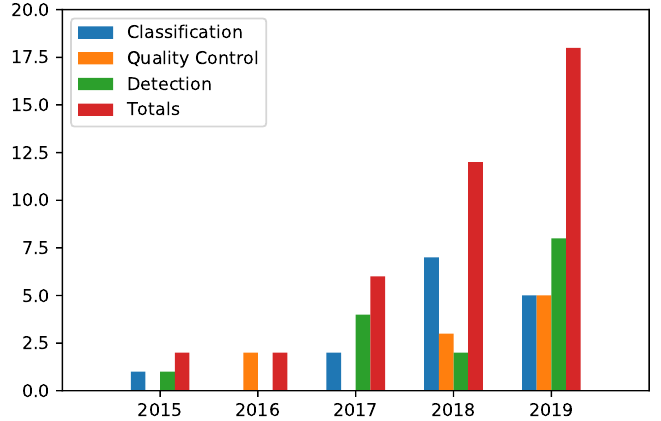
Figure 1. Relationship of the articles based on Convolutional Neural Network (CNN) for fruit image processing, by group and total.